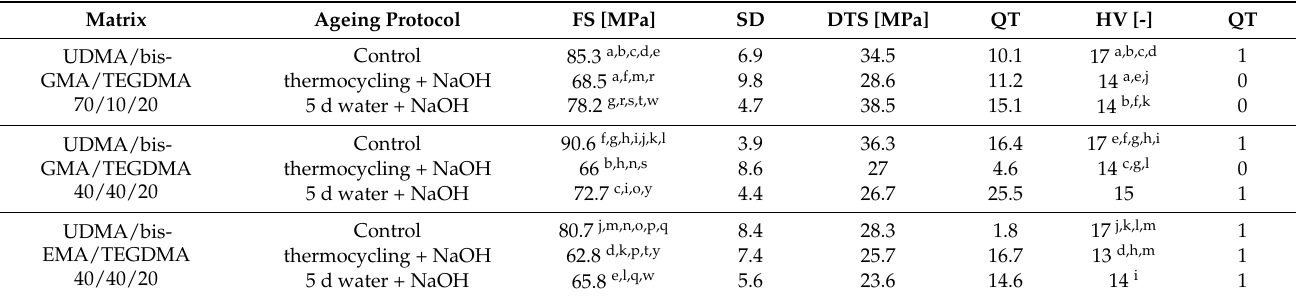
Table 3. The flexural strength (FS), diametral tensile strength (DTS) and hardness (HV) of tested matrices after selected ageing protocols. Normally-distributed variables are given as means with standard deviation, while non-normally distributed variables are given as median with quartile deviation. The results with the same assigned letter show a significant difference at the level of p ≤ 0.05.